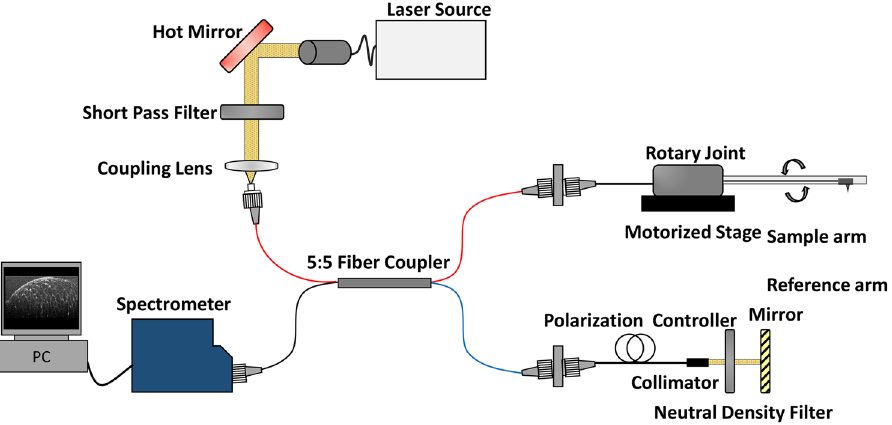
Figure 1. Schematic diagram of the developed endoscopic µ OCT system for three-dimensional vascular